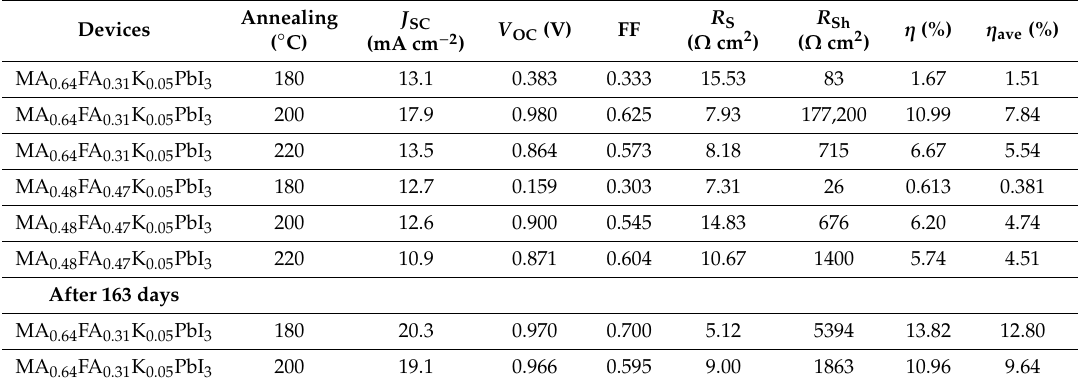
Table 1. Measured photovoltaic parameters of the present perovskite solar cells.